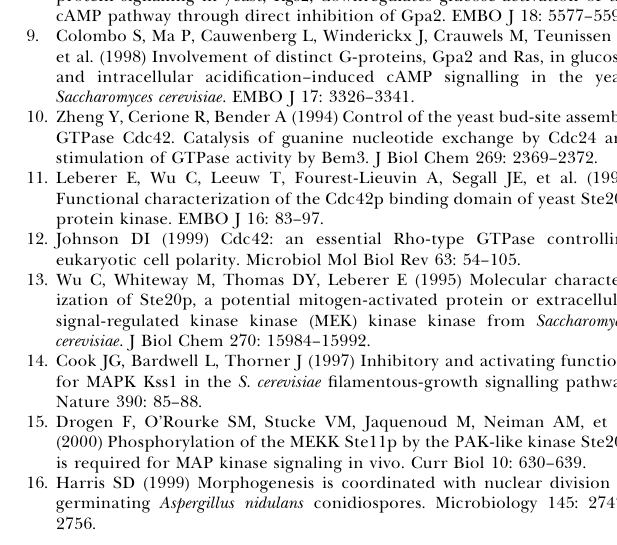
Table S1. Percentage of Germinated Conidia at 25 8 C Found at doi:10.1371/journal.ppat.0030162.st001 (41 KB DOC). Table S2. Percentage of Germinated Conidia at 37 8 C Found at doi:10.1371/journal.ppat.0030162.st002 (54 KB